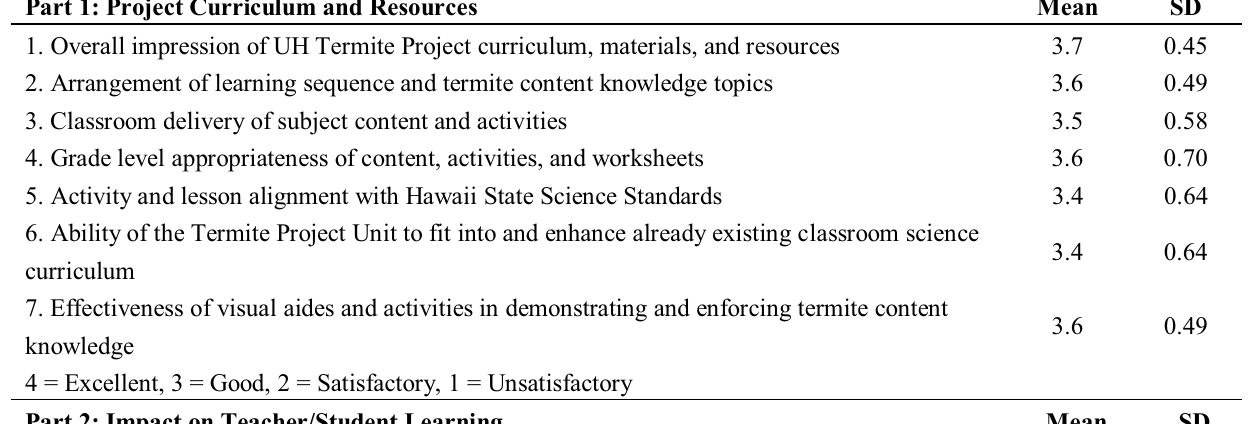
Table 4. Educate to Eradicate (cid:83)(cid:68)(cid:85)(cid:87)(cid:81)(cid:72)(cid:85)(cid:3)(cid:87)(cid:72)(cid:68)(cid:70)(cid:75)(cid:72)(cid:85)(cid:86)(cid:182)(cid:3)(cid:83)(cid:72)(cid:85)(cid:70)(cid:72)(cid:83)(cid:87)(cid:76)(cid:82)(cid:81)(cid:86)(cid:3)(cid:82)(cid:73)(cid:3)(cid:70)(cid:88)(cid:85)(cid:85)(cid:76)(cid:70)(cid:88)(cid:79)(cid:88)(cid:80)(cid:3)(cid:11)(cid:86)(cid:88)(cid:85)(cid:89)(cid:72)(cid:92)(cid:3)(cid:36)(cid:12) . Part 1: Project Curriculum and Resources